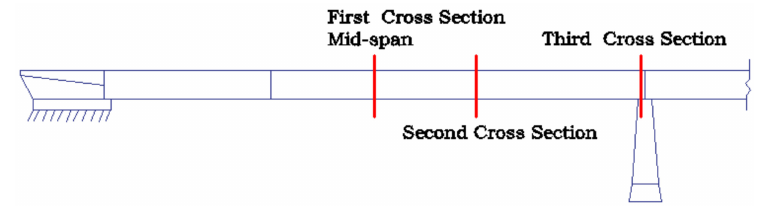
Figure 2. Sensors location of the InfraWatch project.